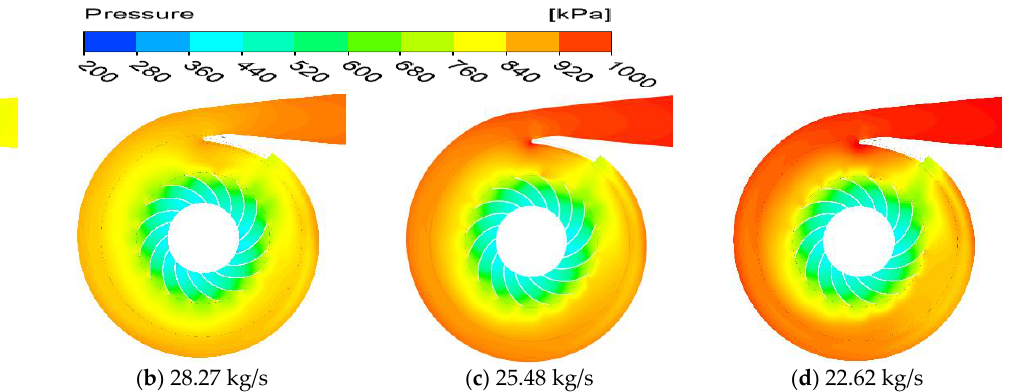
Figure 6. Contours corresponding to a static pressure value illustrated in Figure 6a –din the Z = −12 mm section at different mass-flow rates.